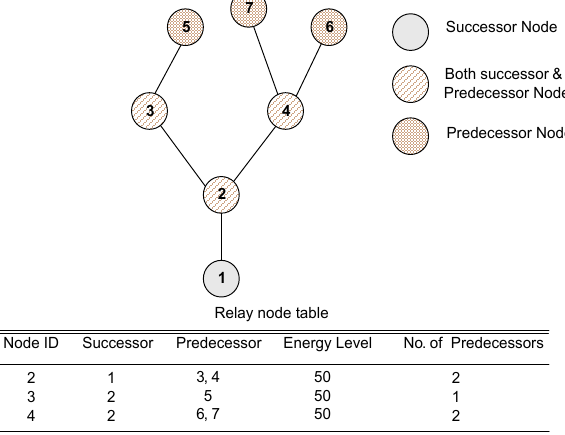
Figure 4. Successor and predecessor nodes with exemplary relay node table.